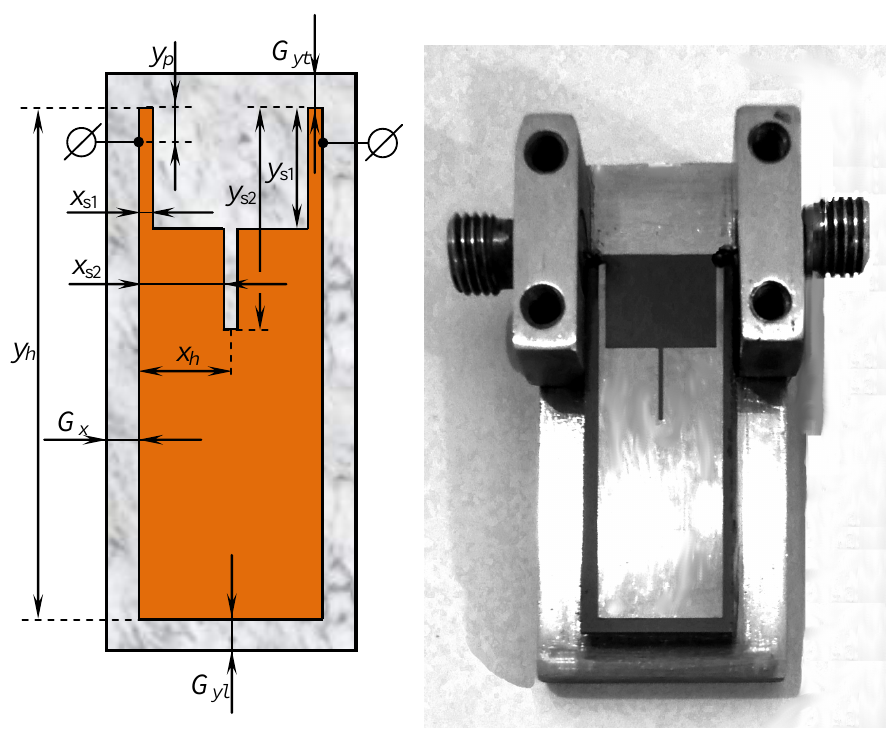
Figure 3. U-shaped (twice slot-split rectangular) 6-mode resonator with an additional cut: layout and manufactured device.